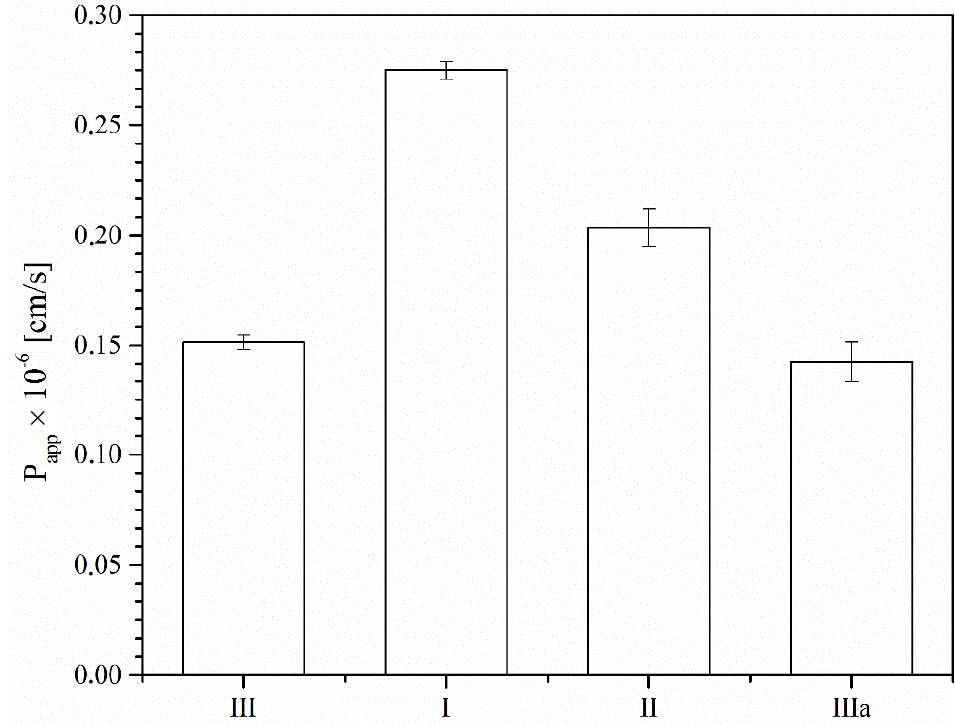
Figure 5. Apparent permeability coefficient ( P app ) for polymorphic forms of